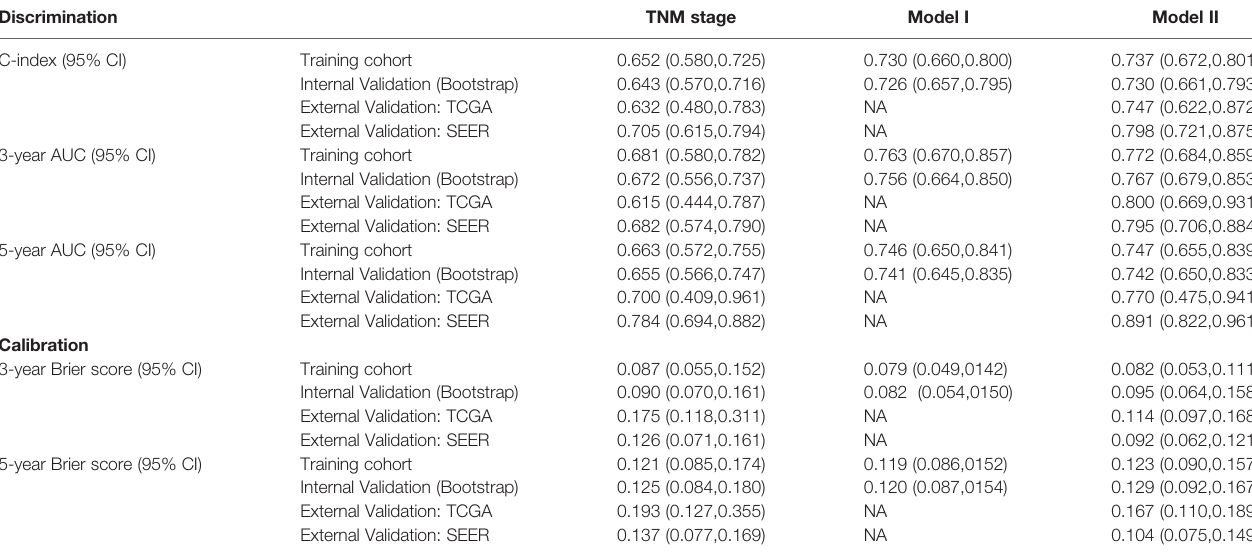
TABLE 3 | Internal and external validations of the prediction